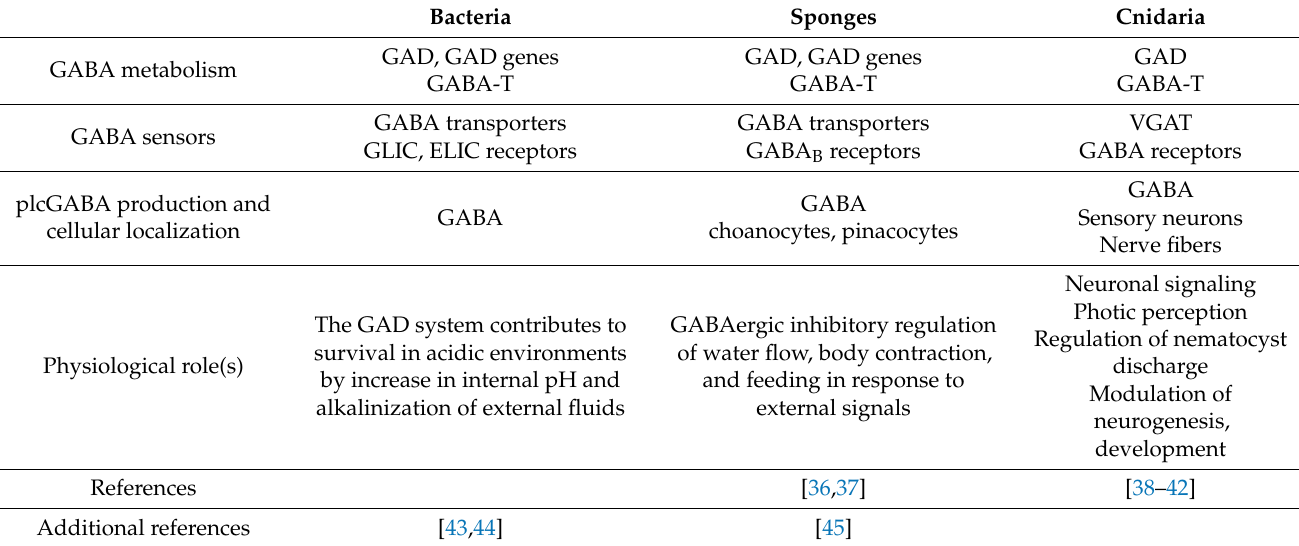
Table 1. Occurrence of GABA and GABA machinery in prokaryotes and non-bilaterian